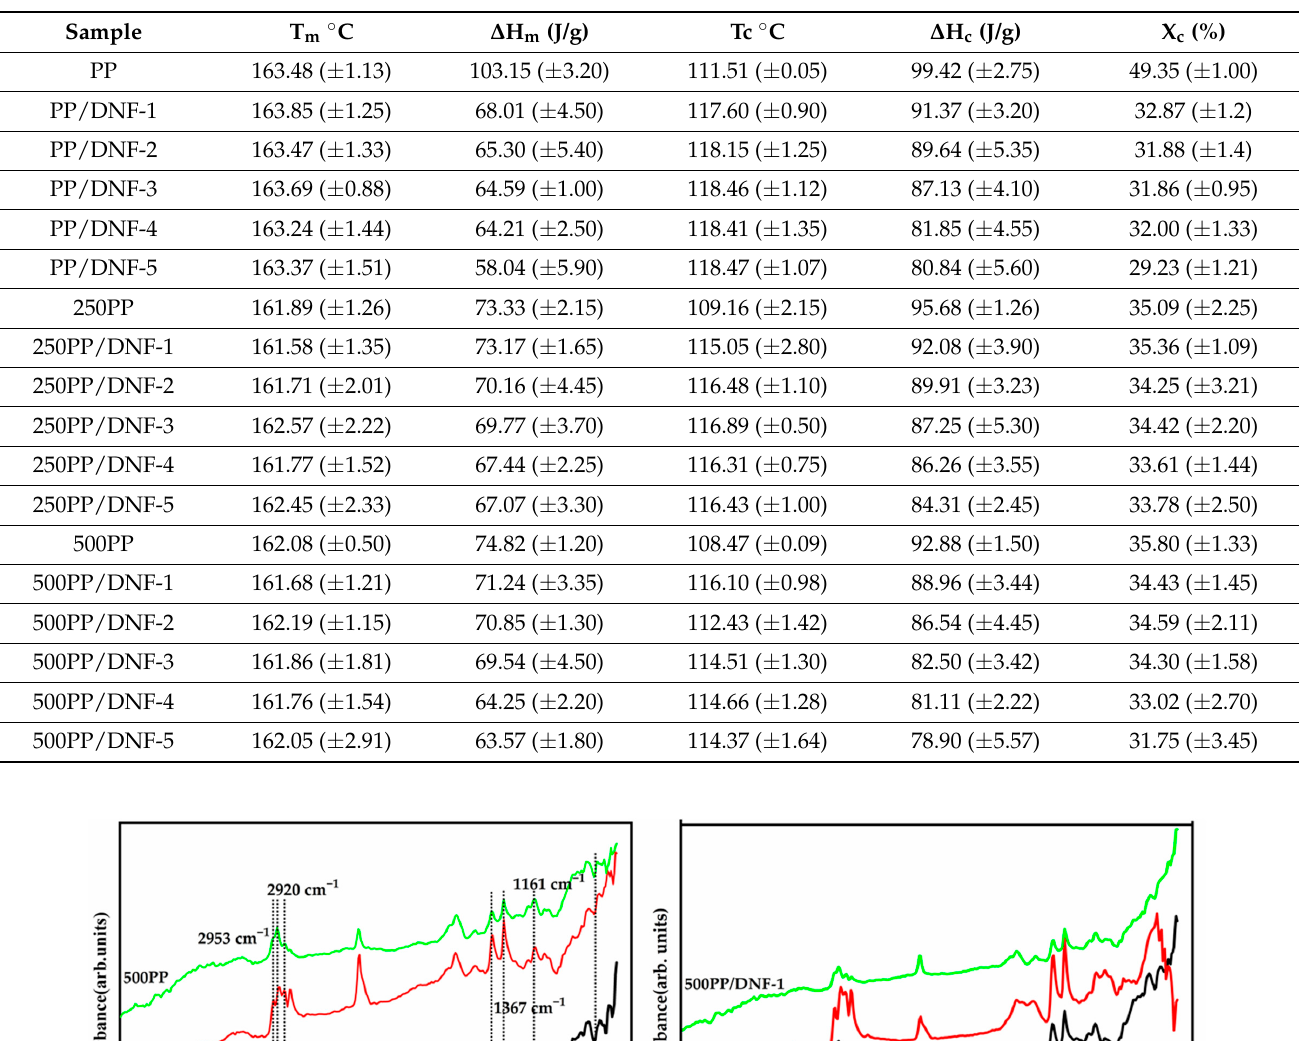
Table 3. DSC characteristics of the composite samples.